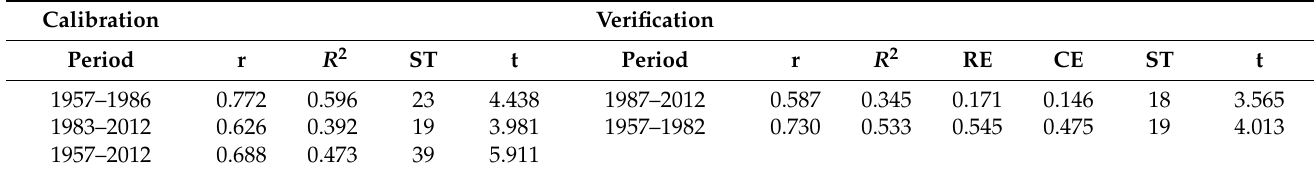
Table 2. Statistics of calibration verification tests for VP JA reconstruction in Ordos. Calibration